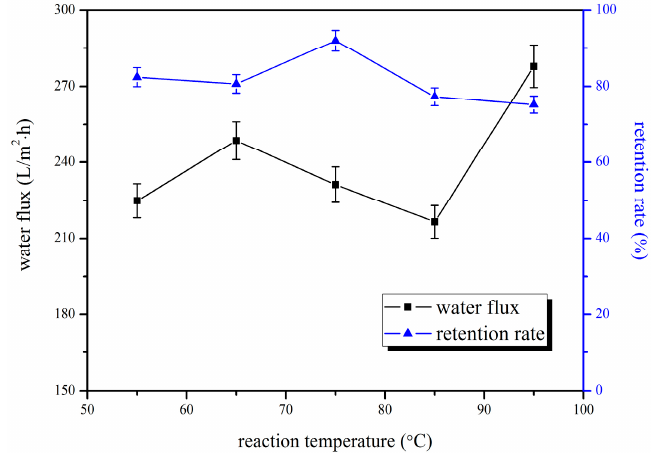
Figure 5. Effect of blending temperature on water flux and retention rate of BSA.